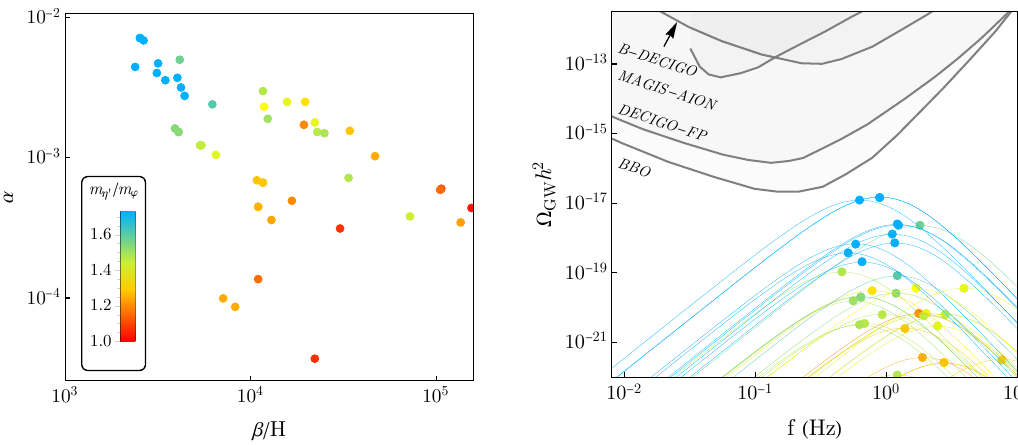
Figure 2 . Thermal parameters (left) and gravitational wave signatures (right) of a chiral phase = 3 and g = 114, for the benchmarks described in the text. For clarity, transition with N F ∗ the peaks of the spectra are indicated with a point. The experimental projections for the Big Bang Observer (BBO) [61–63], Fabry-Perot DECIGO (original proposal) [64], B-DECIGO (scaled- down version) [65], and MAGIS-AION (space-born) [66–68] are plotted. It is seen that the latent heat parameter α is typically larger, and the rate parameter β/H is typically smaller for larger ratio m , associated with a stronger gravitational wave signature (the panels use the same η (cid:31) /m ϕ color